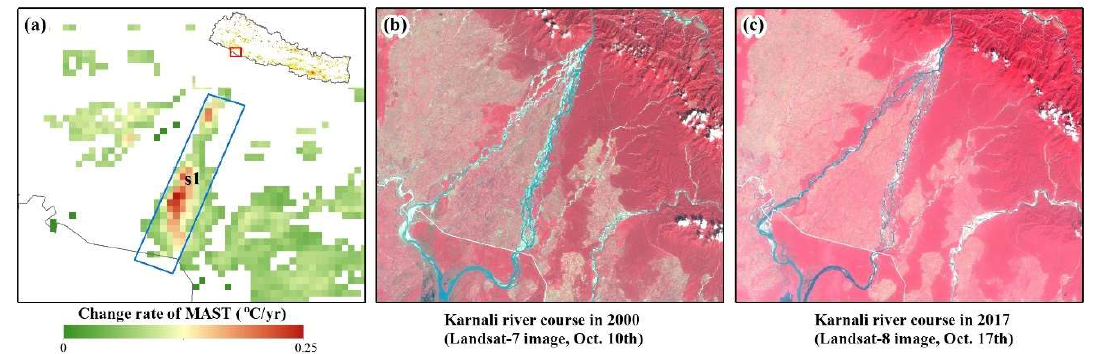
Figure 10. ( a ) Change rate of the daytime MAST in the downstream part of the Karnali River in the Terai Plain during the period from 2000 to 2017, ( b ) false color image of the Karnali River course in 2000 acquired from Landsat-7 satellite data, and ( c ) false color image of the Karnali River course in 2017 acquired from Landsat-8 satellite data.